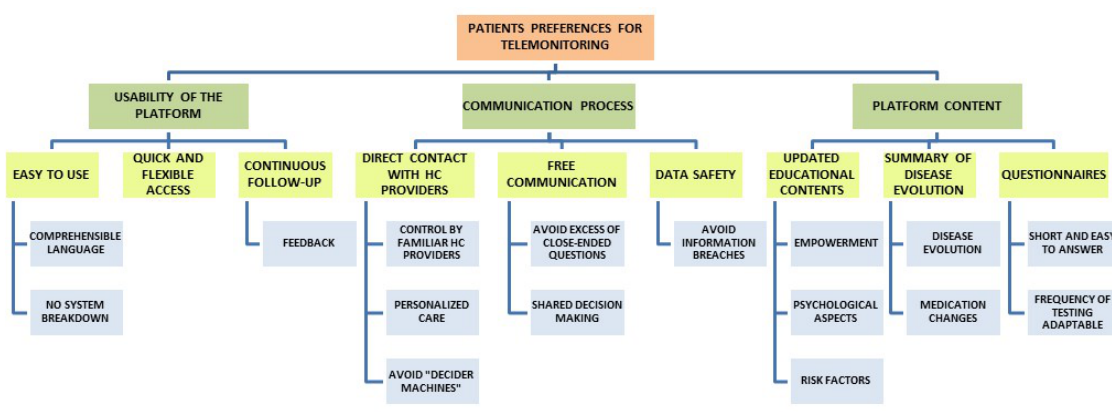
Figure 2. Coding tree representing the codes, categories, and themes that emerged in the focus groups.